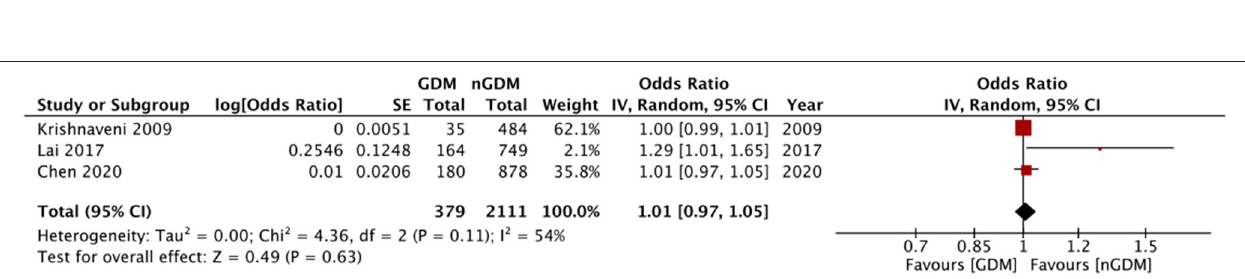
FIGURE 4 | Meta-analysis of adjusted odds ratios assessing relationship between GDM and RBC folate (as continuous variable).